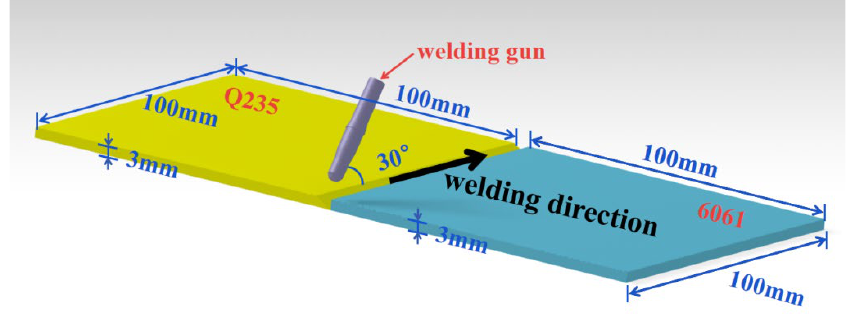
Figure 1. Welding